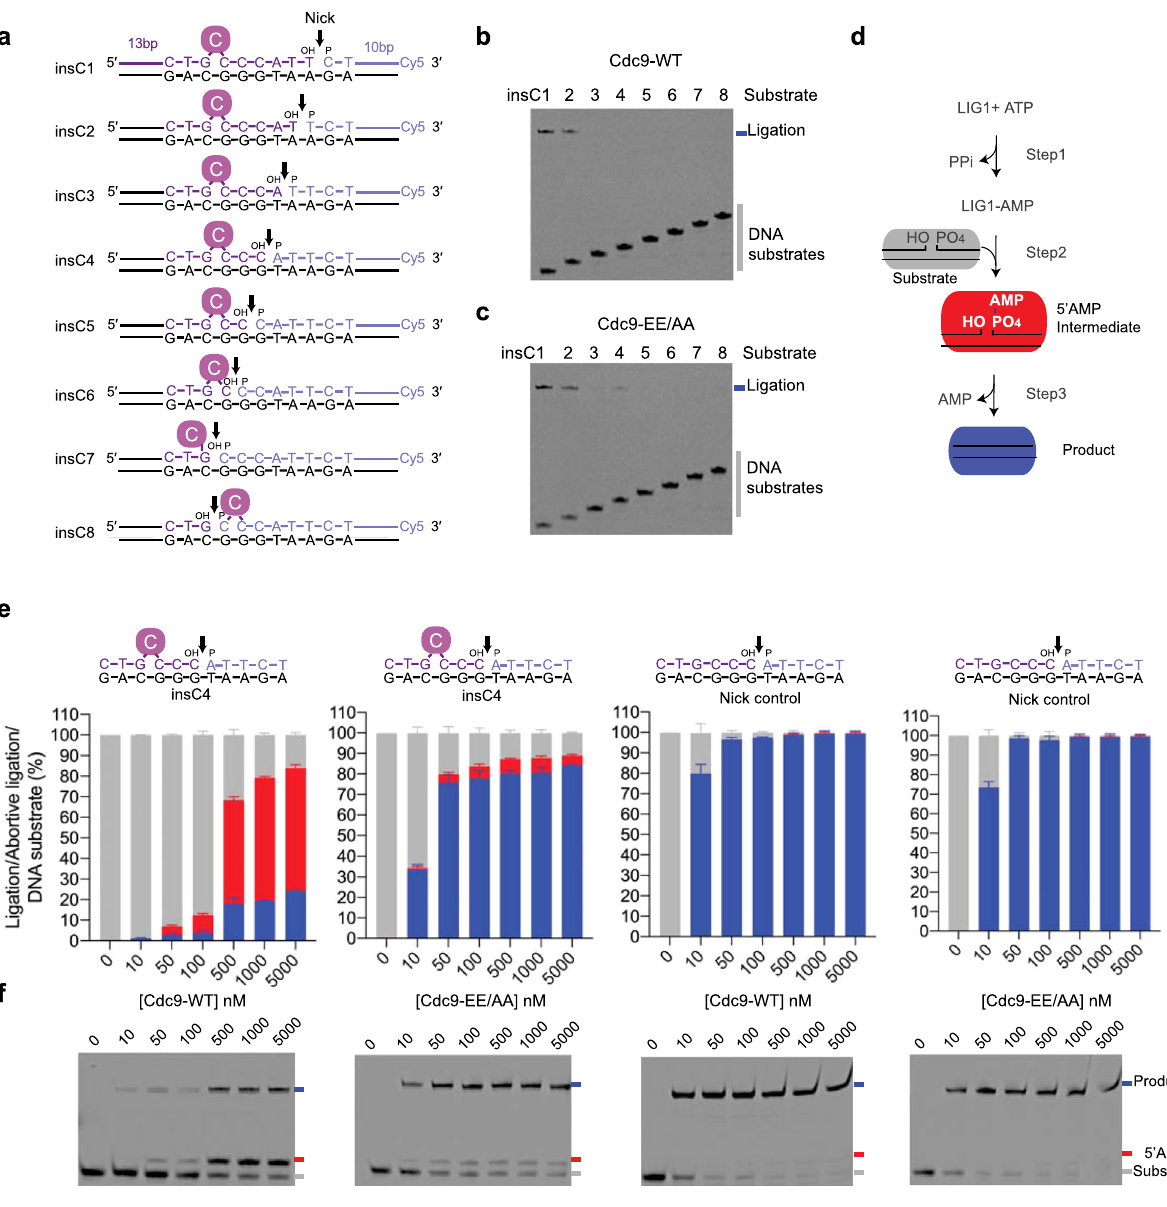
Fig. 5 Cdc9 DNA ligation activity on bulged single-nucleotide insertion substrates. a Schematic of the 3 ′ -Cy5-labeled bulged insertion substrates (insC1 – insC8). The DNA nicks (black arrows) of the bulged insertion substrates are placed at various positions relative to the bulged cytosine base (solid purple circle C) within the cdc9 EE/AA URA3 reporter gene mutation hotspot sequence context. b , c Cdc9 ligation activity on insC substrates. A denaturing gel image of ligation reactions in the presence of 10 mM MgCl 2 , 1 mM ATP, 15 mM NaCl, and 50 nM DNA substrate (insC1 – insC8). Reactions contained 2 nM of Cdc9 WT ( b ) or Cdc9 EE/AA ( c ). Each of these experiments was repeated independently three times with similar results. d The three step ATP- dependent DNA ligation reaction. In Step 1, DNA ligase adenylates its active site lysine. The enzyme-AMP intermediate engages the nicked DNA substrate (gray) and the AMP group is then transferred to the 5 ′ -phosphate of the nicked DNA to form the 5 ′ AMP-DNA intermediate (red) in Step 2. A phosphodiester bond is formed in Step 3 to yield the ligated product (blue) and AMP is released. e Quanti fi cation of total catalytic events on insC4 (left 2 graphs) and control nicked DNA (right 2 graphs) producing ligated product (blue bars) and abortive DNA adenylation (red bars) by Cdc9 WT or Cdc9 EE/AA analyzed with the ImageQuant TL software (GE). Mean± SD ( n = 3 replicates) is displayed for 20 min ligation reactions. f Representative denaturing gel image of Cdc9 ligation reactions on insC4 (left 2 gels) or control nicked DNA (right 2 gels) in the presence of 10 mM MgCl 2 , 1 mM ATP, 115 mM NaCl, and 50 nM DNA substrate. Reactions contained 0 – 5000 nM of Cdc9 WT or Cdc9 EE/AA at 25 °C for 20 min. Each of these experiments was repeated independently three times with similar results. Source data for panels are provided as a Source data fi